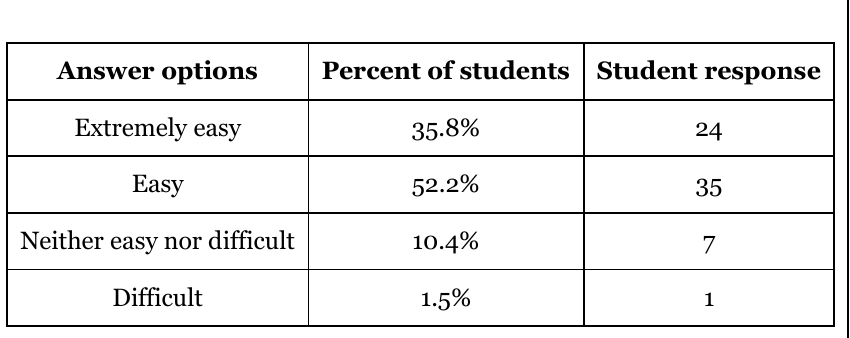
Distribution of Student Responses to the Question: “How Would You Rate Your Overall Ability to Find What You Need on the Critical Health Psychology Course Site?”